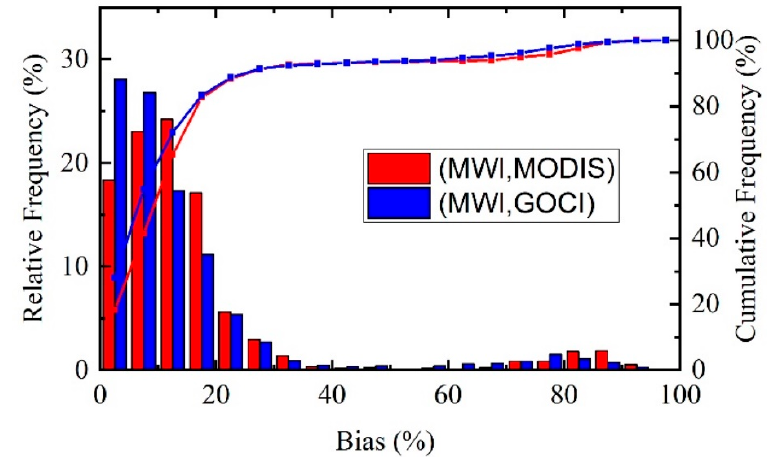
Figure 12. Statistics of frequency distribution of biases between TG-2/MWI-derived TSM and Terra/MODIS-derived TSM, TG-2/MWI-derived TSM and CMOS/GOCI-derived TSM.